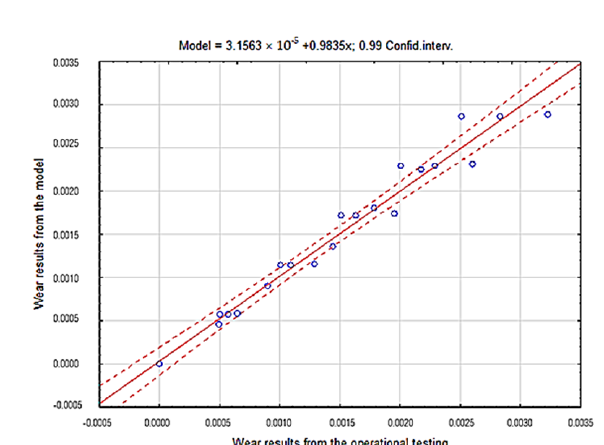
Figure 15. The course of the correlation of empirical data with theoretical data for steel in light soil.